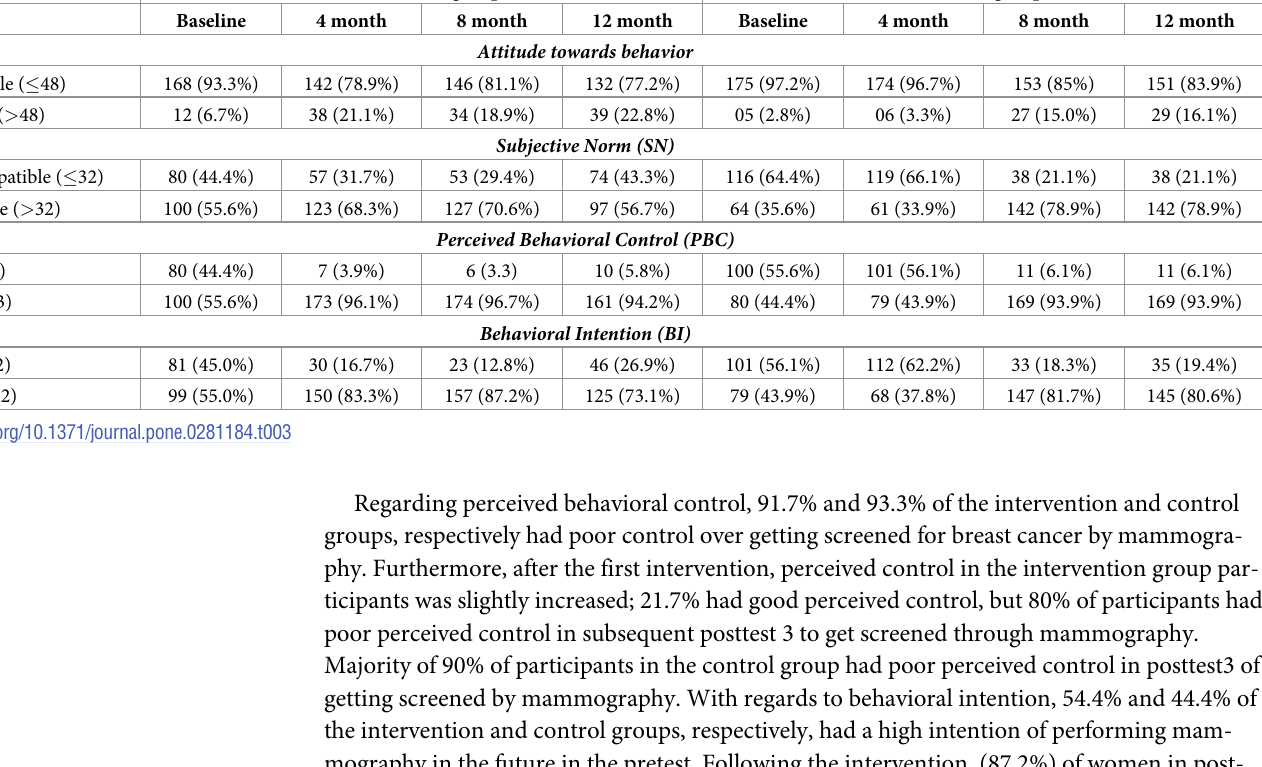
Table 3. Descriptive statistics to perform breast self-examination based on the constructs of the theory of planned behavior at different endpoints (n = 360). Categories